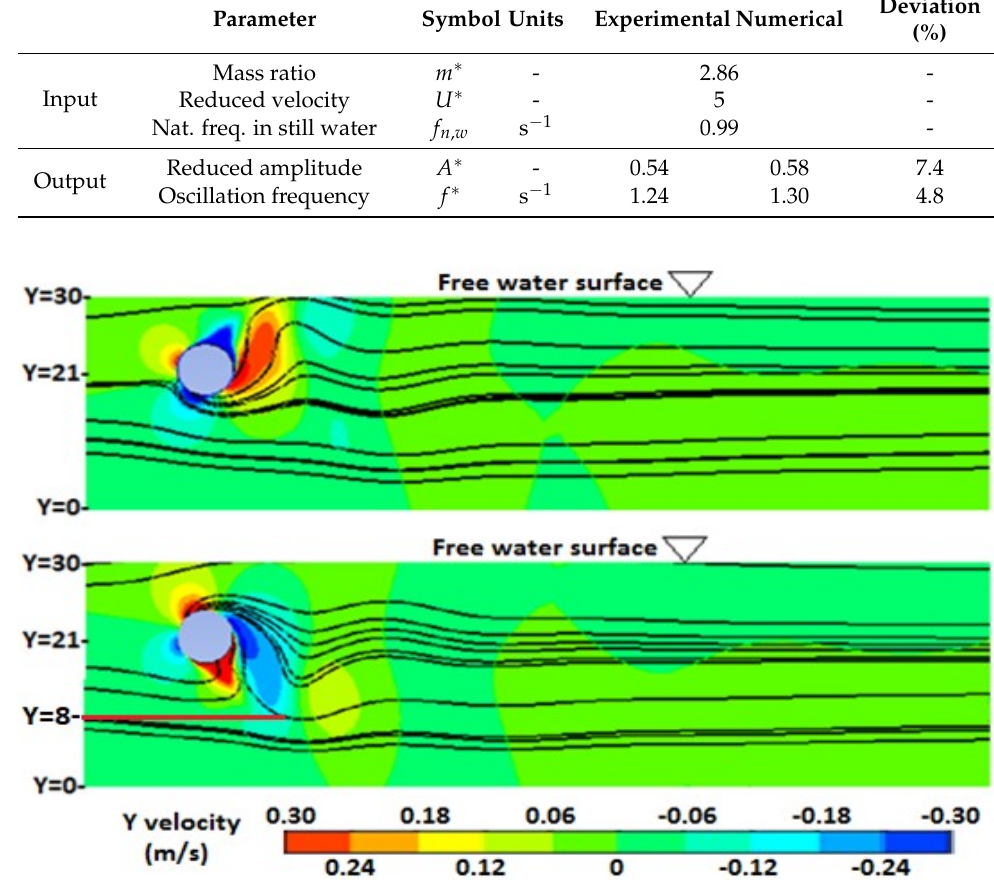
Figure 9. Vertical velocity created by cylinder oscillation when cylinder is at neutral (middle) position. Above contour is captured when cylinder is moving down, below contour is captured when cylinder is moving up.